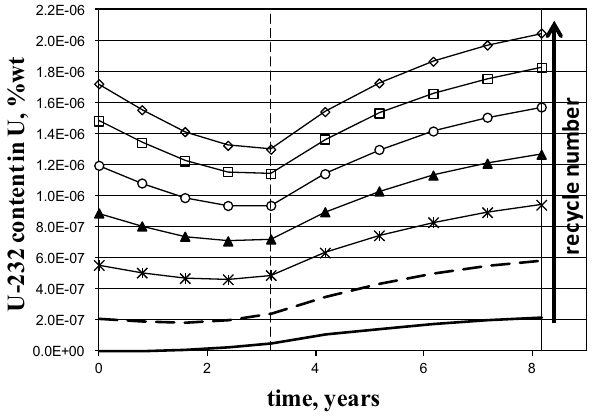
Fig. 9. The 232 U content in REMIX(UOX) fuel.